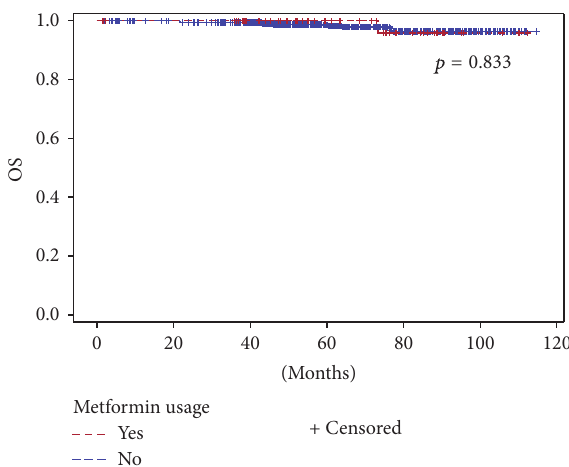
Figure 2: Overall survival according to metformin